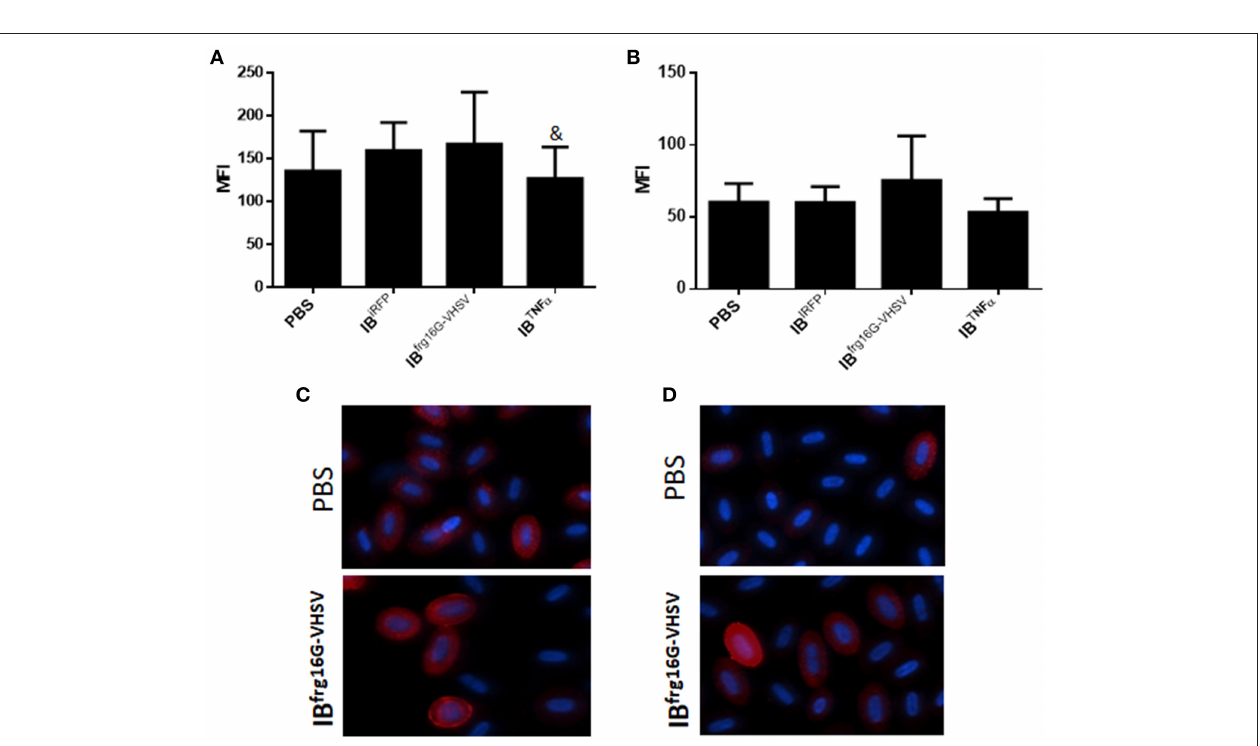
FIGURE 7 | Protein expression analysis of RBCs from rainbow trout injected intravenously with 5.5 mg/kg of IB iRFP , IB TNF α , IB frg16G − VHSV or PBS at 48h post-injection. (A) Interferon related protein MX and (B) chemokine IL8 Mean Fluorescence Intensity (MFI) measured by flow cytometry. Data represent mean ± SD ( n = 4). Mann-Whitney test was performed between each condition and control cells (treated with PBS or IB iRFP ). & P -value < 0.05, compared to IB iRFP . Representative immunofluorescence images of RBCs stained with (C) anti-MX and (D) anti-IL8, taken with 60 × magnification. Protein stain in red, DAPI (blue) for nuclei stain.